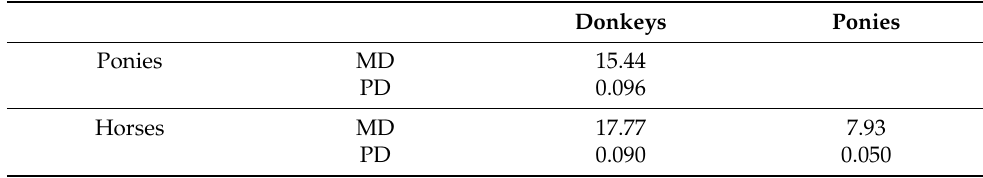
Table 4. Mahalanobis distances (MD) and Procrustes distances (PD) among the equid head shape categories (donkeys, ponies, and